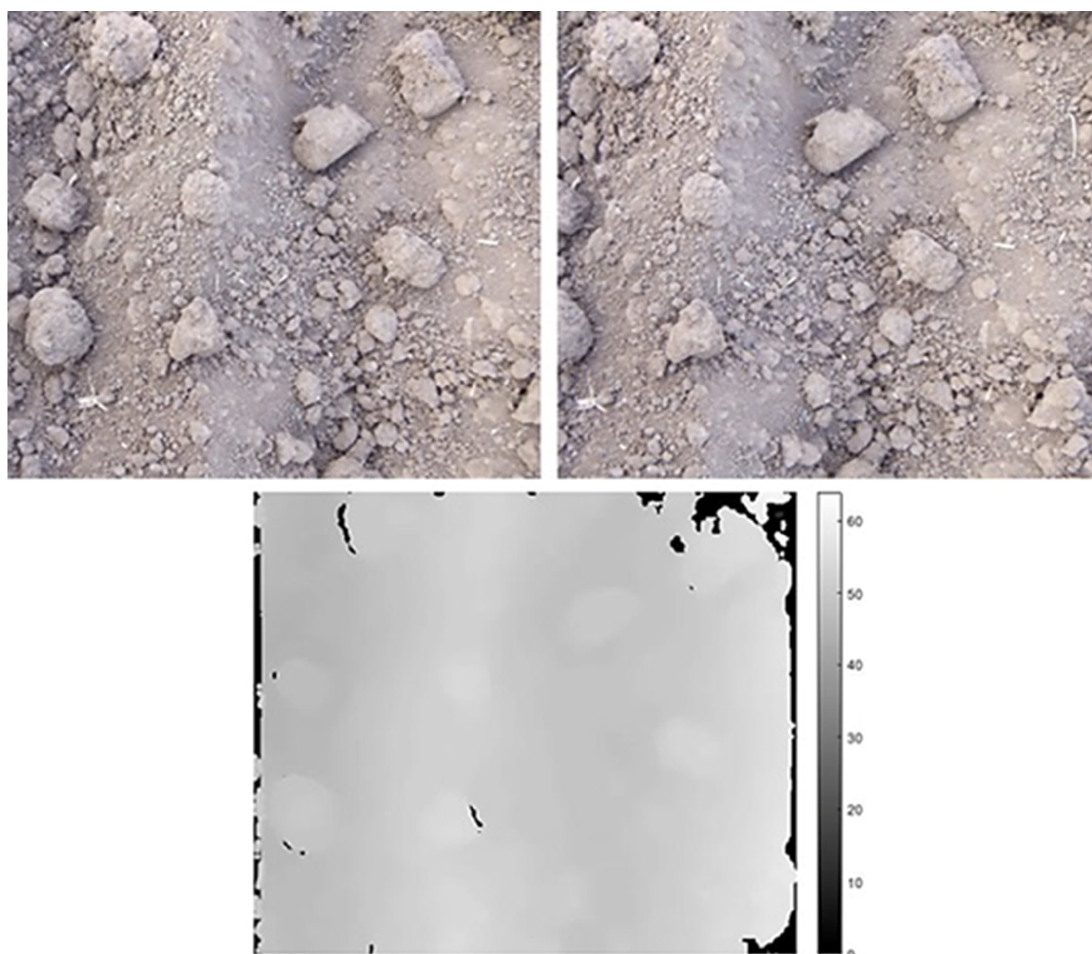
Figure 4. An example of stereo-pair image with corresponding depth image.